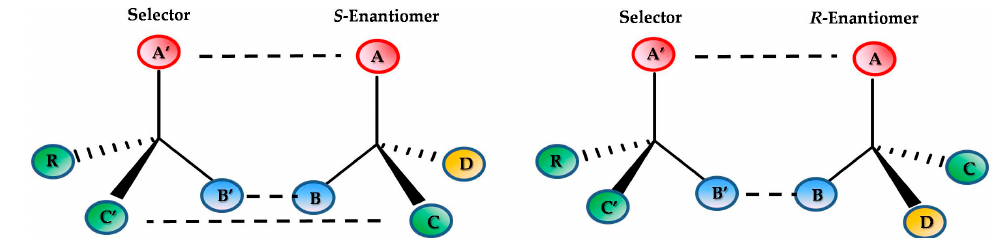
Figure 1. Scheme of “Three-point” interaction